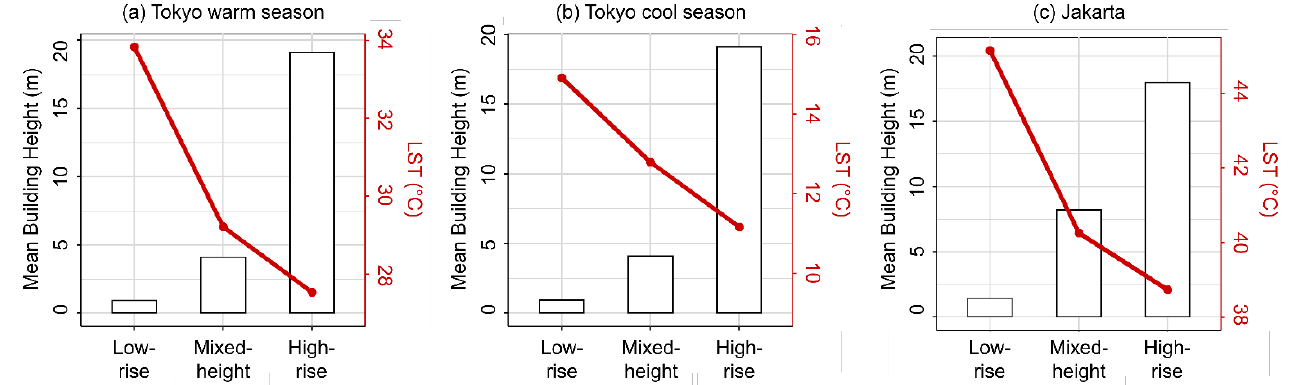
Figure 6. Mean building height and mean LST of different sample areas in ( a ) Tokyo warm season, ( b ) Tokyo cool season, and ( c ) Jakarta.